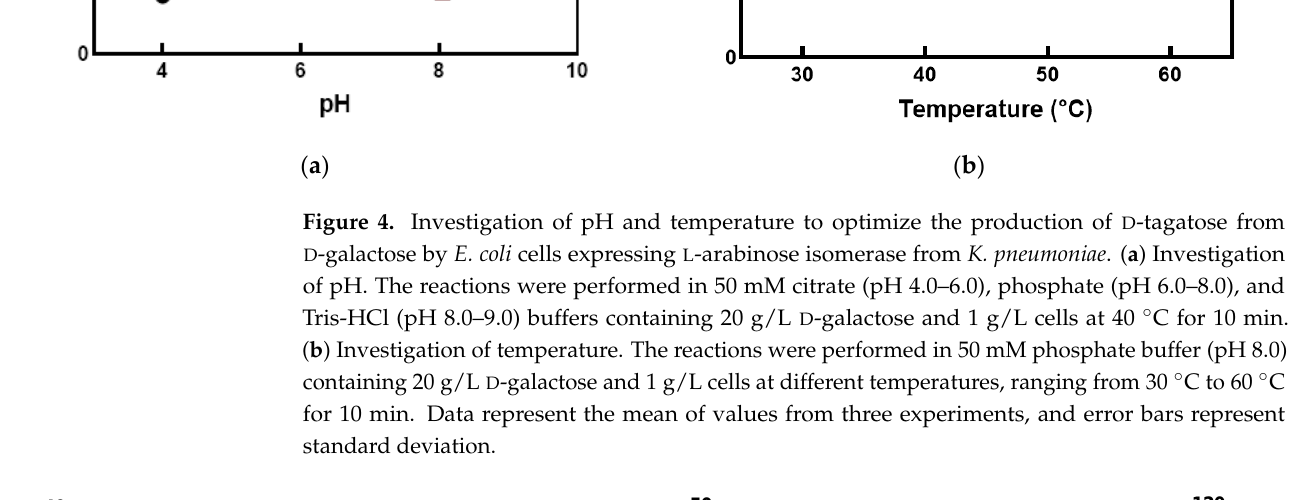
Figure 4. Investigation of pH and temperature to optimize the production of D -tagatose from D - galactose by E. coli cells expressing L -arabinose isomerase from K. pneumoniae . ( a ) Investigation of pH. The reactions were performed in 50 mM citrate (pH 4.0–6.0), phosphate (pH 6.0–8.0), and Tris- HCl (pH 8.0–9.0) buffers containing 20 g/L D -galactose and 1 g/L cells at 40 °C for 10 min. ( b ) Inves- tigation of temperature. The reactions were performed in 50 mM phosphate buffer (pH 8.0) contain- ing 20 g/L D -galactose and 1 g/L cells at different temperatures, ranging from 30 °C to 60 °C for 10 min. Data represent the mean of values from three experiments, and error bars represent standard deviation.